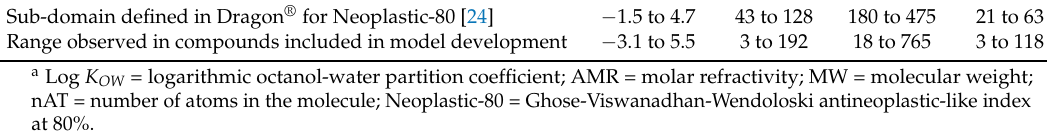
Range observed in compounds included in model